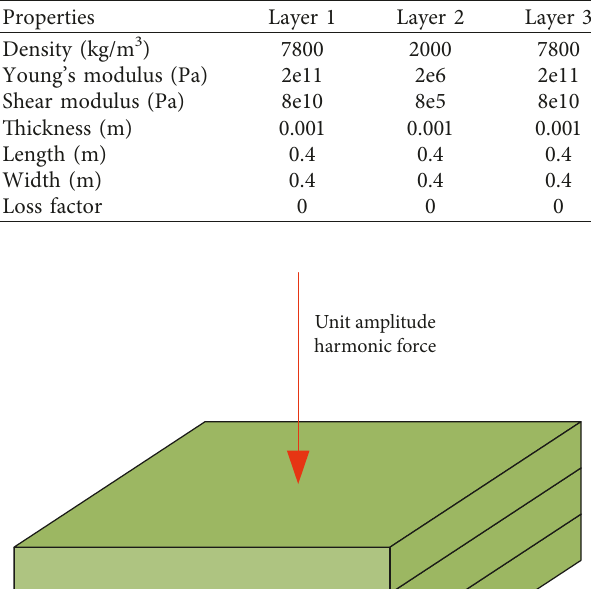
Table 4: Plate parameters for curve fitting.